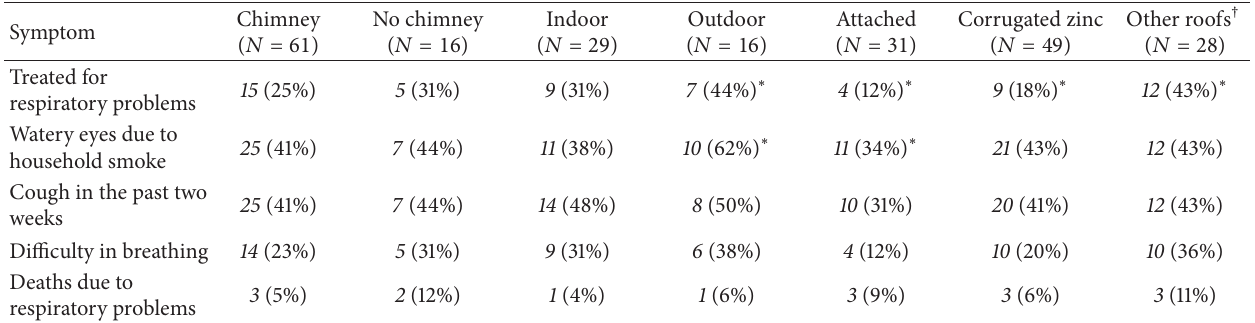
Table 3: Comparison of respiratory symptoms by household characteristic.